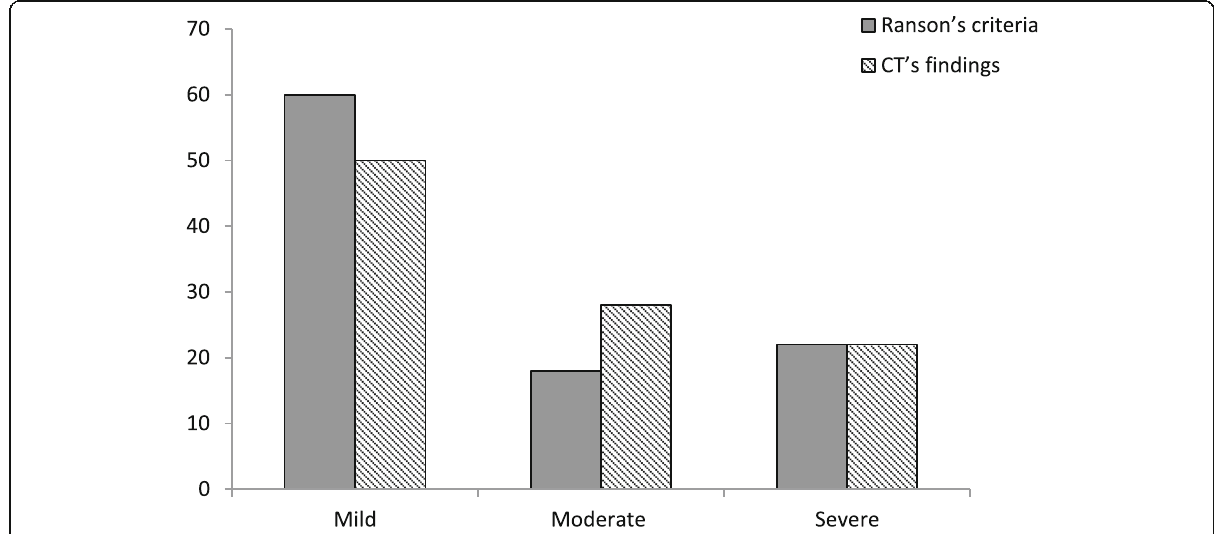
Fig. 1 Severity of pancreatitis based on Ranson ’ s criteria and CTs ’